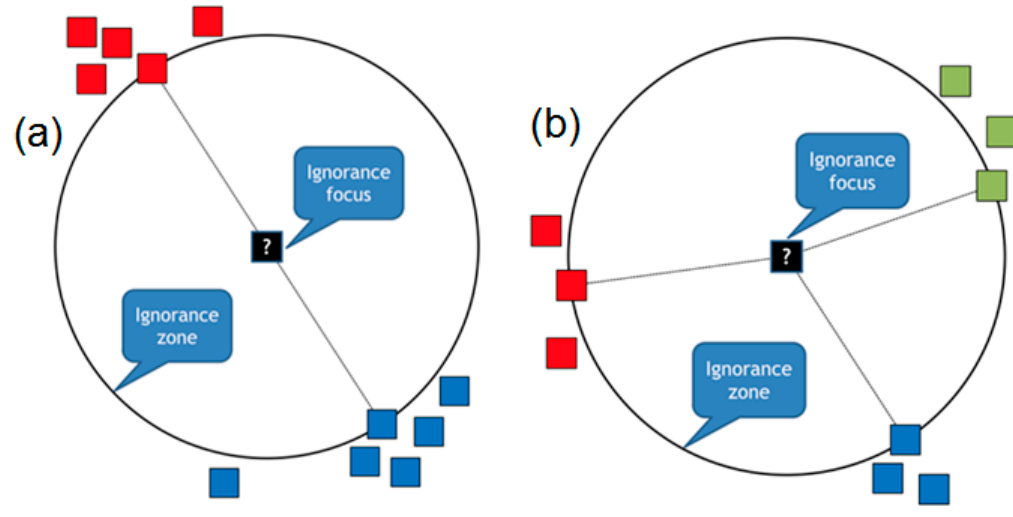
Figure 2. ( a ) The two-point ignorance zone and its ignorance focus; ( b ) The three-point ignorance zone and its focus. In more generic n -dimensional spaces, we will have n variations of the ignorance zones constructed by 2, 3, . . . , n + 1 parent points, and the zones will be the n -dimensional hyperspheres.